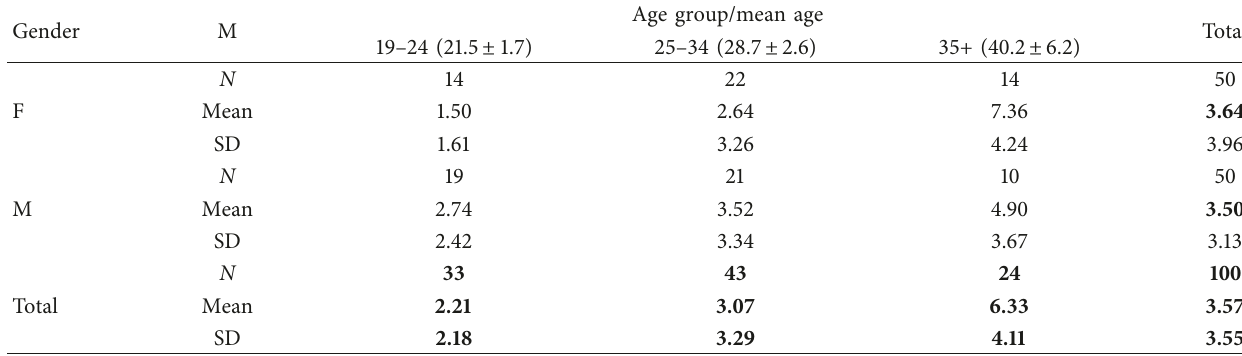
Table 4: Missing (M) values of adult inmates according to age group and gender.